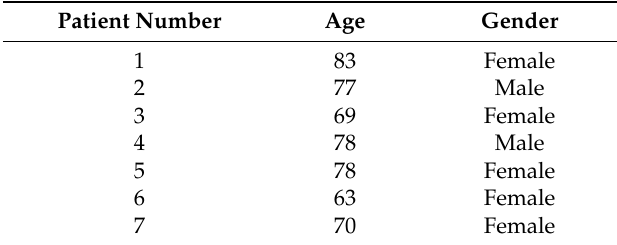
Table 1. Summary of the age and gender of the